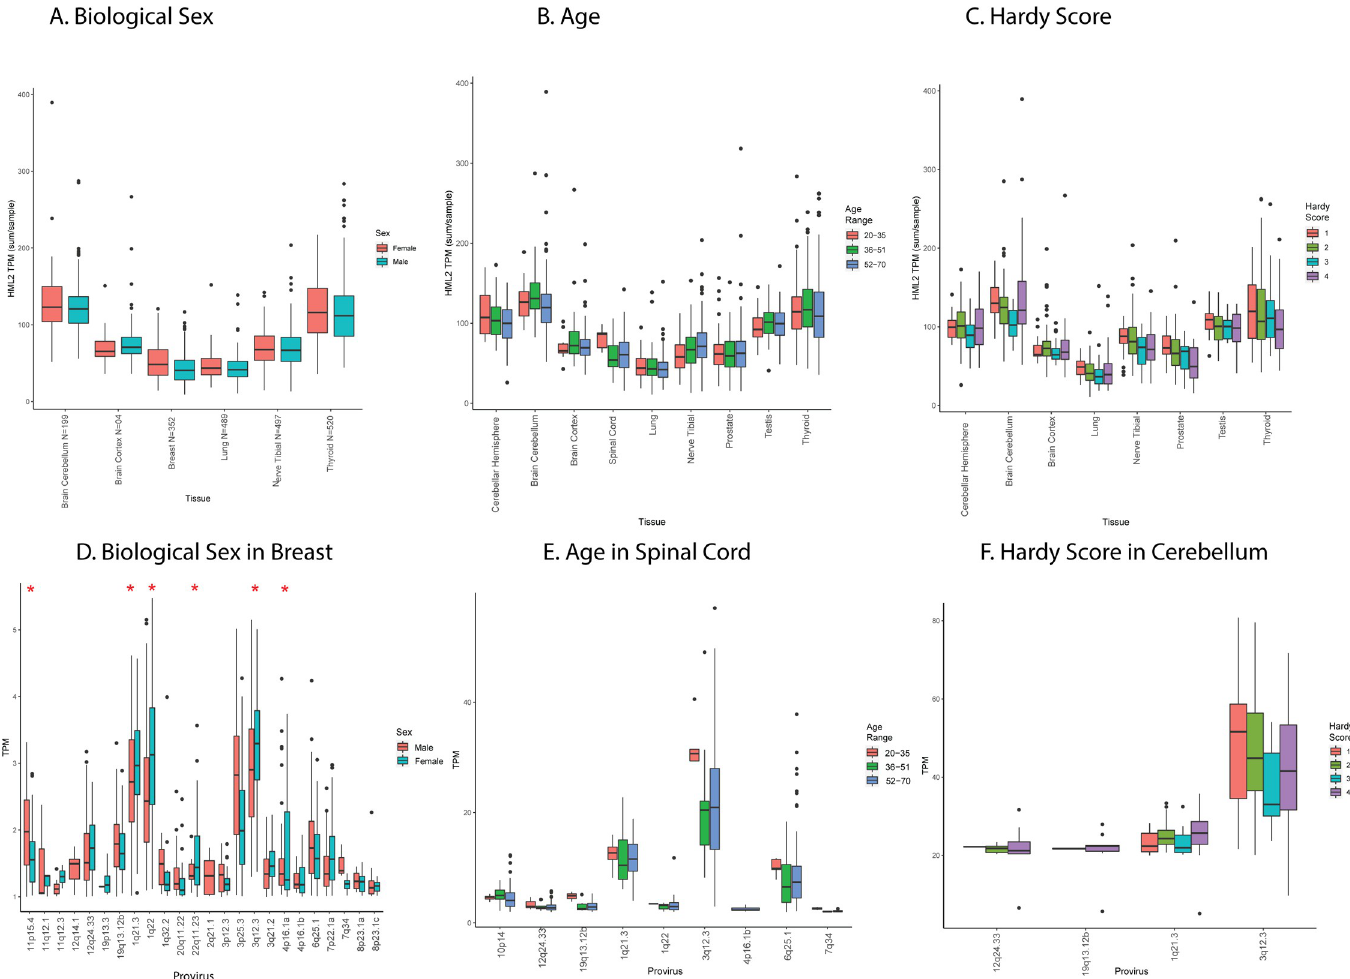
Fig 7. Effects of covariates and morbidities on HML-2 expression. ( A , B , C ) Average TPM per tissue of interest of total HML-2 expression for donors separated by biological sex, age, and Hardy score plotted as in Fig 3A. Biological sex was identified by Y chromosome expression: Age was divided into 3 groups (20–35, 35–51, and 52– 70); Hardy score is broken down into 4 categories. 1 is the fastest death; 4 is the slowest. ( D , E , F ) Expression of individual proviruses in the indicated body sites (breast, spinal cord, and cerebellum). Average TPM of all proviruses expressed greater than or equal to a TPM of 1 is displayed from all samples of each body site. Red asterisks indicate statistically significant ( p < 0.5) differences ( t test). All TPM data are from the relevant sheets of S1 Data. Covariate information for each donor can be found in S1 Data on the SUBJID_Pheno sheet. HML, human mouse mammary tumor virus-like; TPM, transcripts per